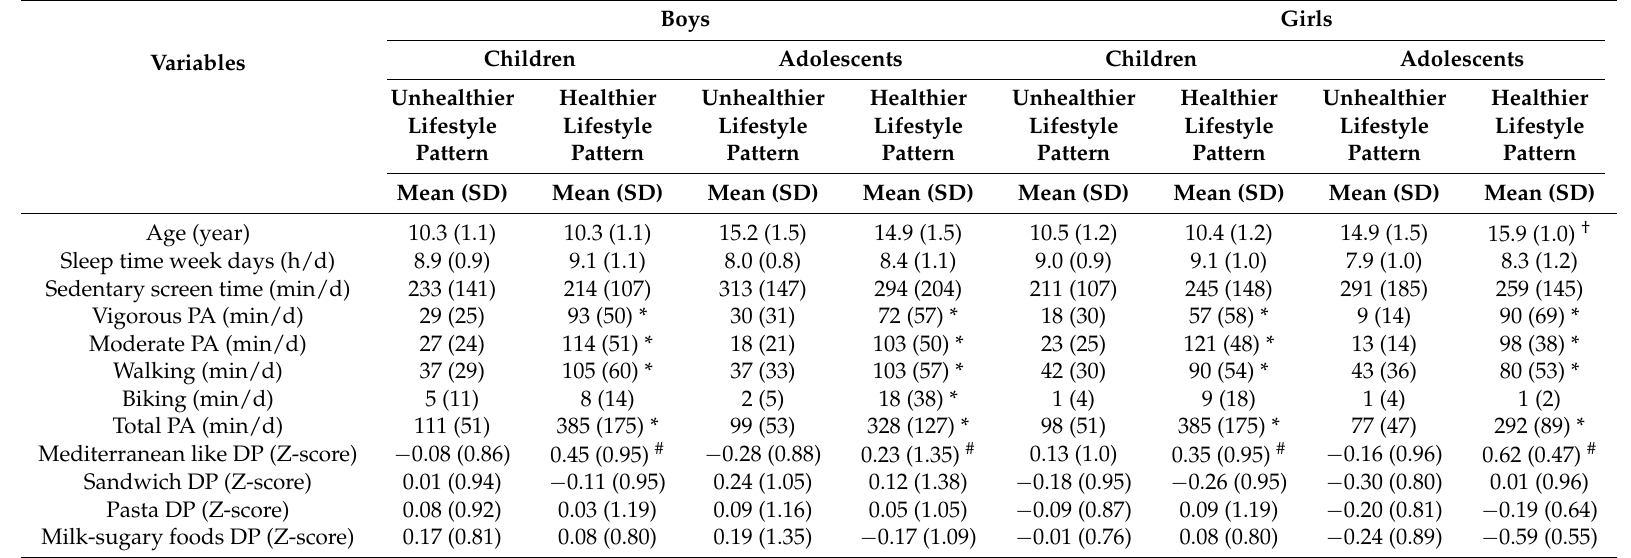
Table 2. Physical activity behaviors, sedentary screen time, sleep time on weekdays, and dietary patterns Z-score in the final lifestyle patterns a in children and adolescents by